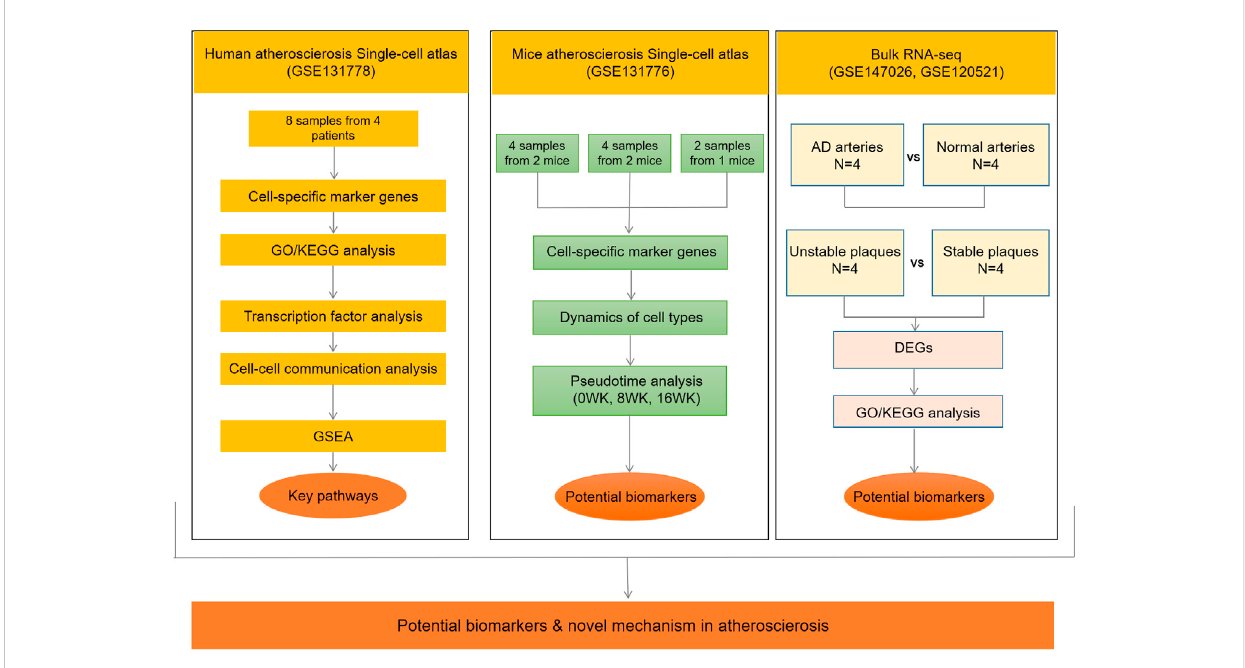
FIGURE 1 Flow diagram of the entire study design. AD, aortic dissection; DEGs, differentially expressed genes; GSEA, gene set enrichment analysis; 0WK: 0- week; 8WK: 8-weeks; and 16WK: 16-weeks. GSE131778 (right coronary artery), GSE131776 (aortic root and ascending aorta), GSE147026 (aortic media tissue), GSE120521 (carotid